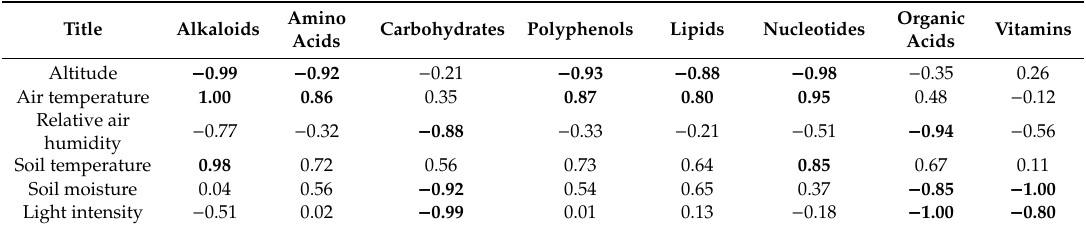
Table 3. Correlation analysis between meteorological factors and major metabolite classes in wolfberry